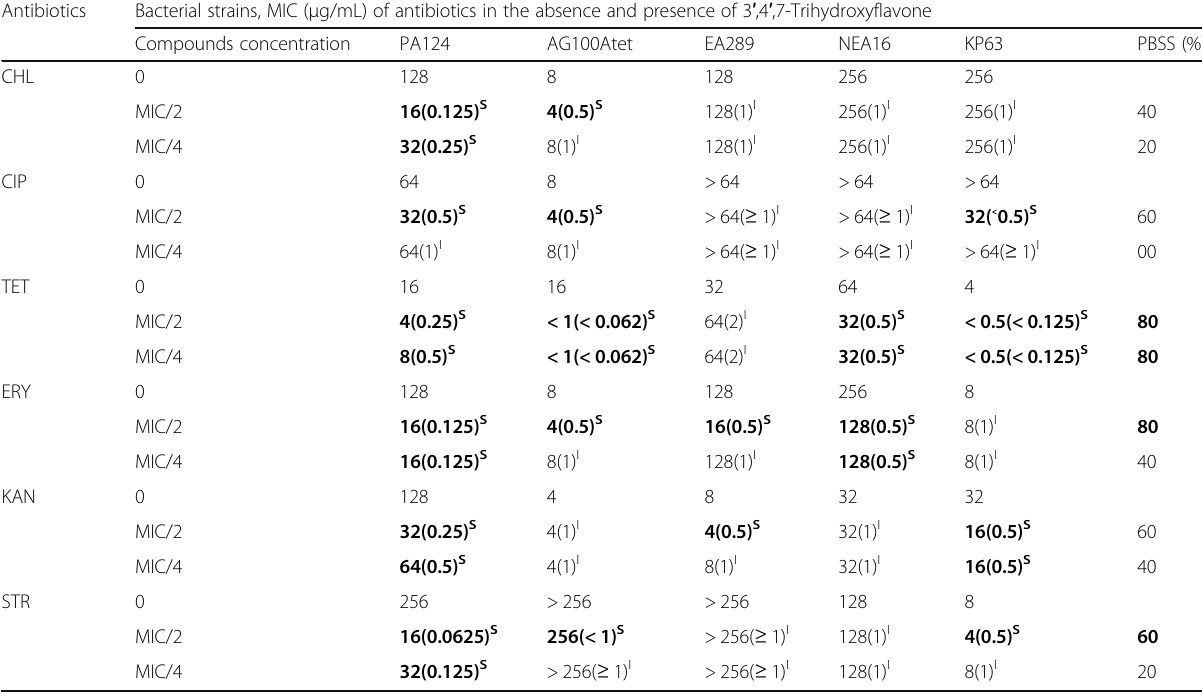
Table 4 MIC of different antibiotics after the association with 3 ′ ,4 ′ ,7-Trihydroxyflavone MIC/2, MIC/4 against five MDR bacteria strains Antibiotics Bacterial strains, MIC ( μ g/mL) of antibiotics in the absence and presence of 3 ′ ,4 ′ ,7-Trihydroxyflavone Compounds